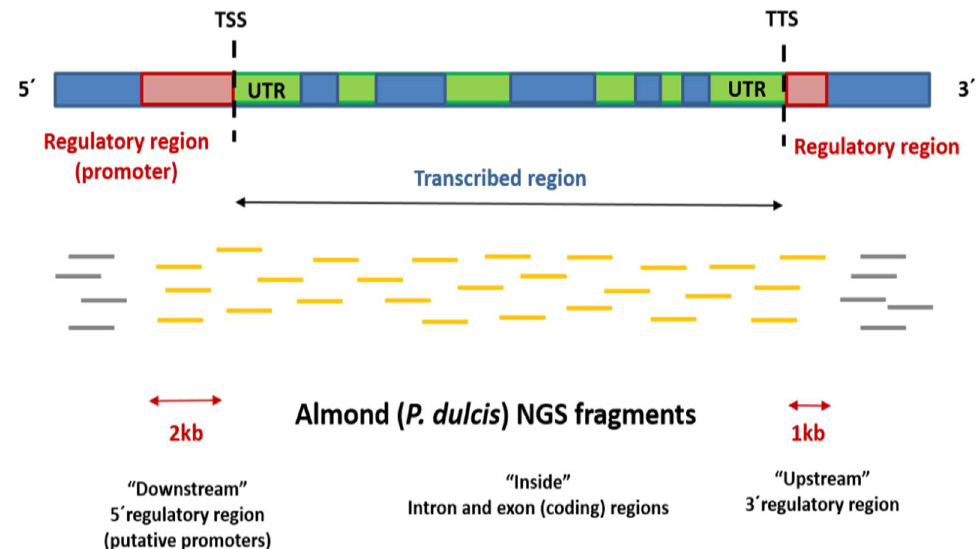
Figure 7. Schematic representation of a plant gene and classification of almond ( Prunus dulcis ) DMFs mapped in the P. persica genome. DMFs mapping from 2 kb upstream TSS to 1 kb downstream TTS were selected for functional annotation (fragments colored in orange). DMFs were classified according to the gene position—downstream, inside, or upstream—with respect to the fragment-mapping region. Fragments mapped in intergenic regions (colored in grey) were discarded as putative gene regulatory regions. TSS: Transcriptional Start Site, UTR: Untranslated Transcription Region, TTS: Transcriptional Terminal Site. Exons and introns within the transcribed region are colored in blue and green, respectively.